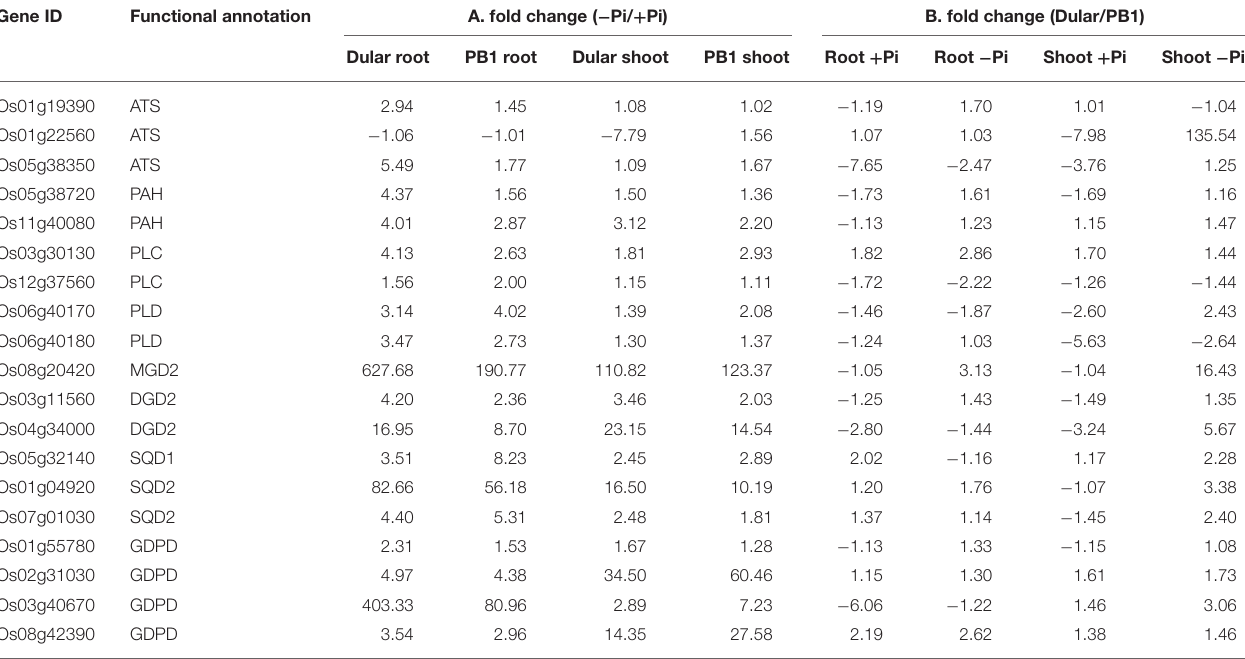
TABLE 2 | Expression profile of differentially expressed genes encoding key enzymes in lipid metabolic pathway. Gene